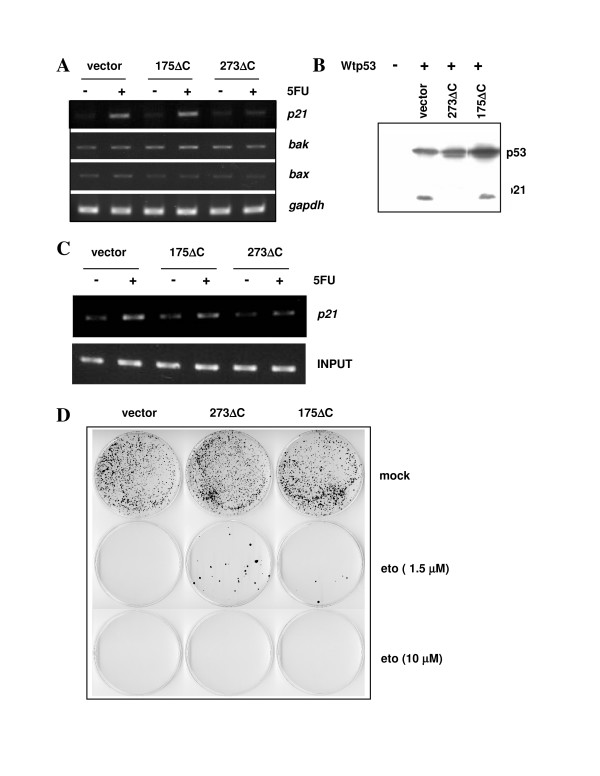
Dominant inhibition of wt p53 by the mutants 175ΔC and 273ΔC. (A) RT-PCR on the three HCT116 cell lines infected to express empty vector, 175ΔC, or 273ΔC, after mock-treatment (-) or treatment with 375 mM 5FU (+) for 24 h. The expression levels of the p21Waf/Cip1, bak, and bax genes, and of the gapdh control gene, are documented. (B) HCT116 p53-/- cells were transiently transfected to express empty vector or wt p53 in combination with one of the indicated mutants. The Western blots on 15 μg of total protein extract prepared at 24 h after transfection were incubated with anti-p53 antibody DO-1 (1:2000) or anti-p21 antibody (1:1000). (C) Chromatin immunoprecipitation (ChIP) assay on the three indicated cell lines. Depicted are the relative quantities of p21 promoter DNA precipitable with anti-p53 antibody DO-1 at 24 h after treatment with 375 μM 5FU vs. mock treatment. INPUT shows that the total quantities of p21 promoter DNA in the cell samples were similar. (D) Colony formation assay on HCT116 cells infected with empty vector or vector expressing 175ΔC or 273ΔC. One thousand live cells were seeded onto 10 cm dishes and were mock-treated or received between 10 μM and 0.5 μM etoposide. After 10 days in culture, colonies were fixed and stained with crystal violet, as described in Materials and methods.